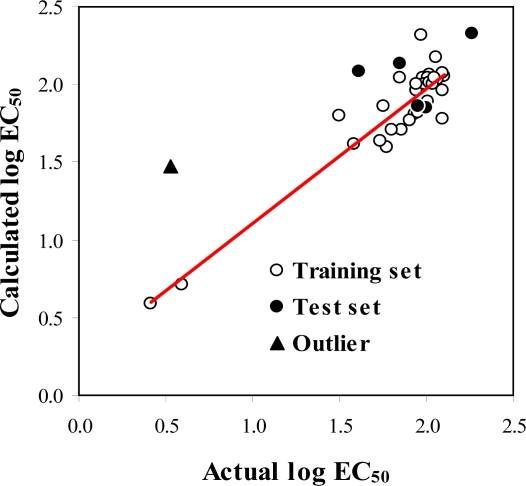
Plot of actual versus calculated log EC50 of the training and test set molecules.